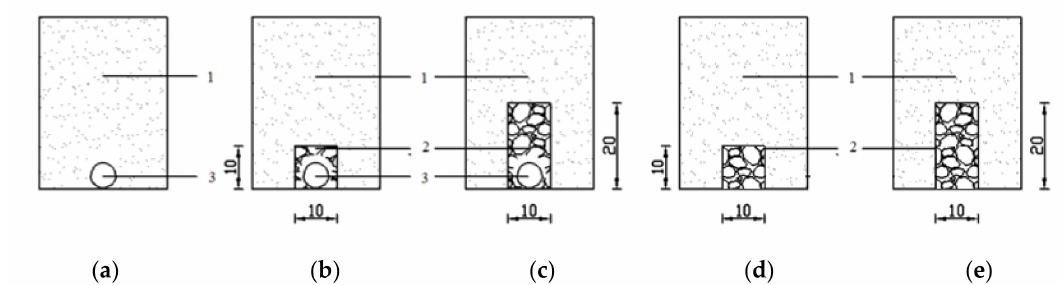
Figure 2. Schematic diagram of conventional, improved and filter subsurface drainage, ( a ) CD, ( b ) ID-1, ( c ) ID-2, ( d ) FD-1, ( e ) FD-2; Unit: mm. 1. Soil medium (80–120 mesh quartz sand); 2. Highly permeable materials (2–4 mm-diameter quartz sand); 3. Subsurface drainage pipe.